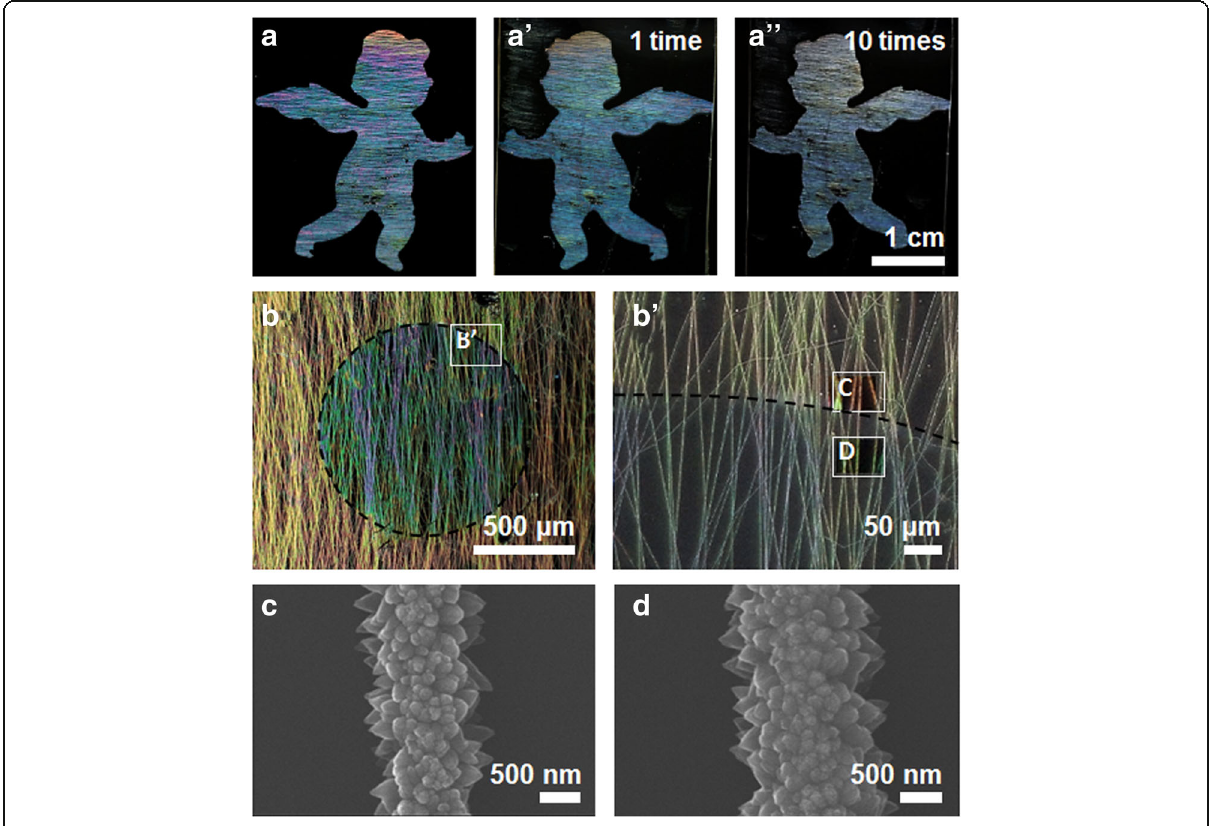
Fig. 3 a Structural color pattern of an angel and the pattern duplicated 1 time (A ’ ) and 10 times (A ” ) using polydimethylsiloxane. b Pattern for which two colors were obtained by varying the synthesis time and ( b ’ ) an image of the edge portion observed with an optical microscope. c , d Scanning electron microscope images of nanofibers in the outer and inner parts of b